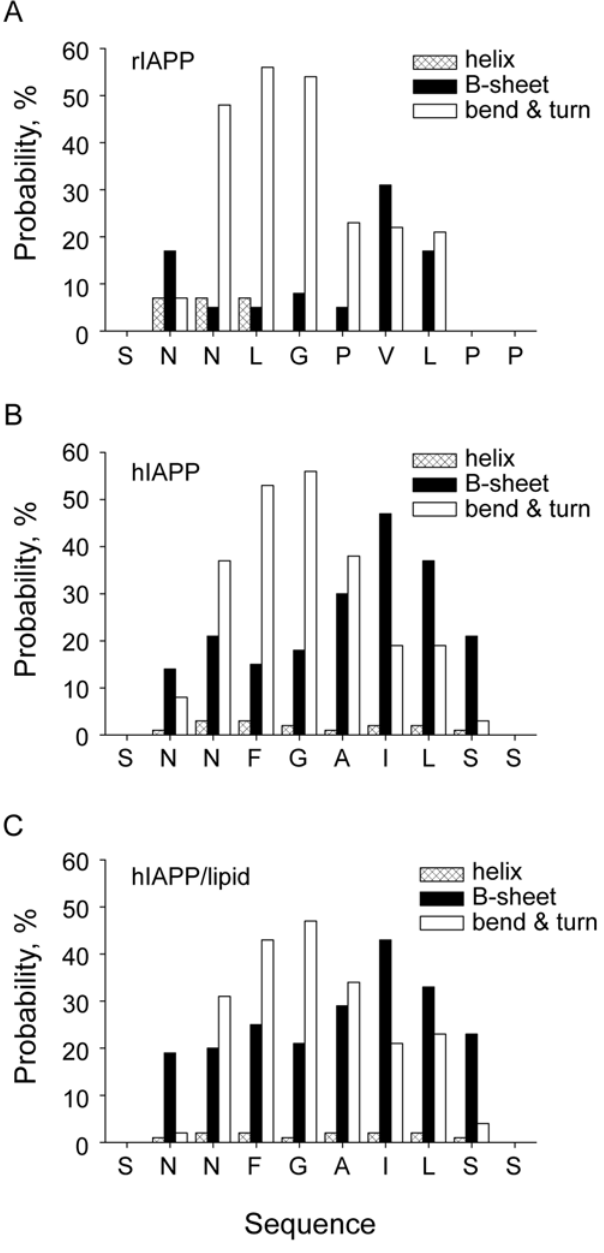
Figure 5. Secondary structure propensity of residues in rIAPP 20–29 and hIAPP 20–29 . The secondary structures are assessed by DSSP package.